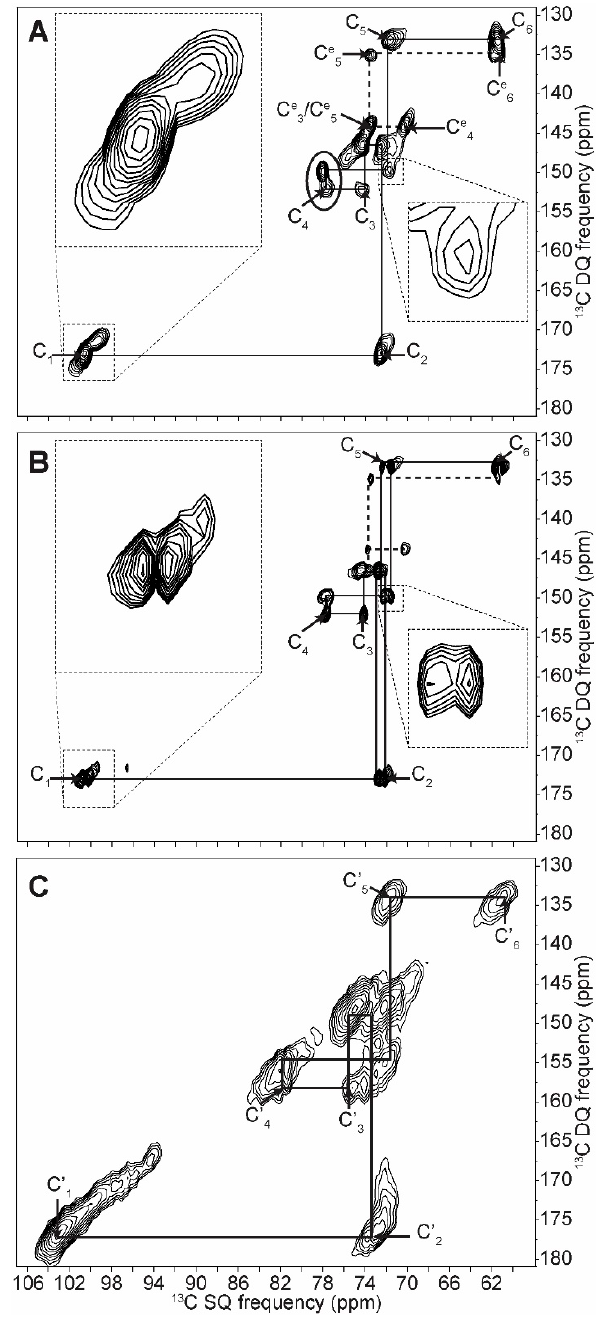
Figure 3. NOE (Nuclear Overhauser Effect)-INADEQUATE 2D SQ/DQ (single quantum/double quantum) 13 C solid-state NMR spectra of pure amylopectin A-type starch ( A ), retrograded native C. reinhardtii B-type starch ( B ) and amorphous dry native C. reinhardtii starch ( C ). Continuous lines are correlation pathways for the main starch constituents ( α -1,4 and α -1,6 linked glucans), while dashed lines correspond to non-reducing end groups. Zooms correspond to carbon 1 in C 1 –C 2 correlation and to carbon 5 in the C 5 –C 4 correlation on the left and right side zooms, respectively. On ( A ), C e X designate carbons in non-reducing end-groups. To compare end groups signals between 2D spectra, the intensities are normalized using the C 4 area circled in ( A